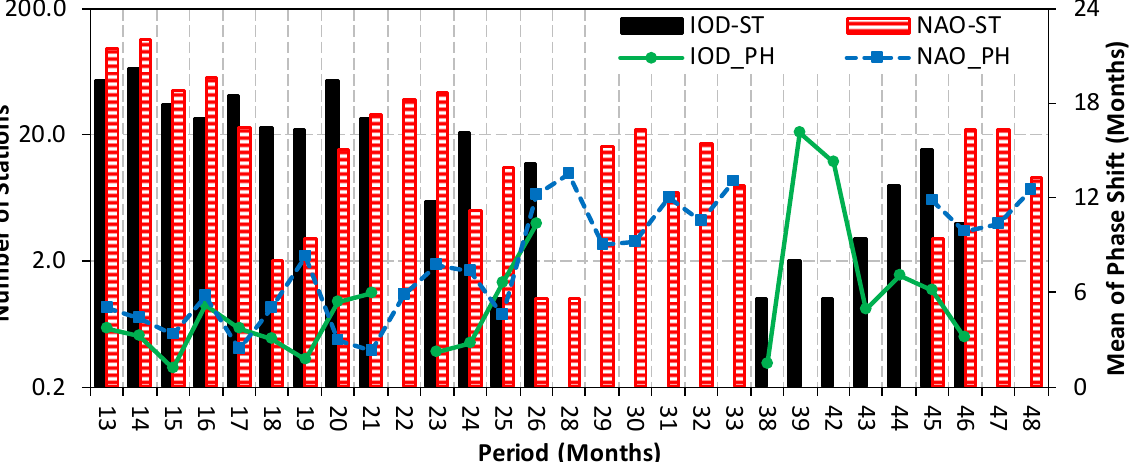
Figure 13. Numbers of stations and means of phase shift values according to the periods after the cross-spectral analyses.